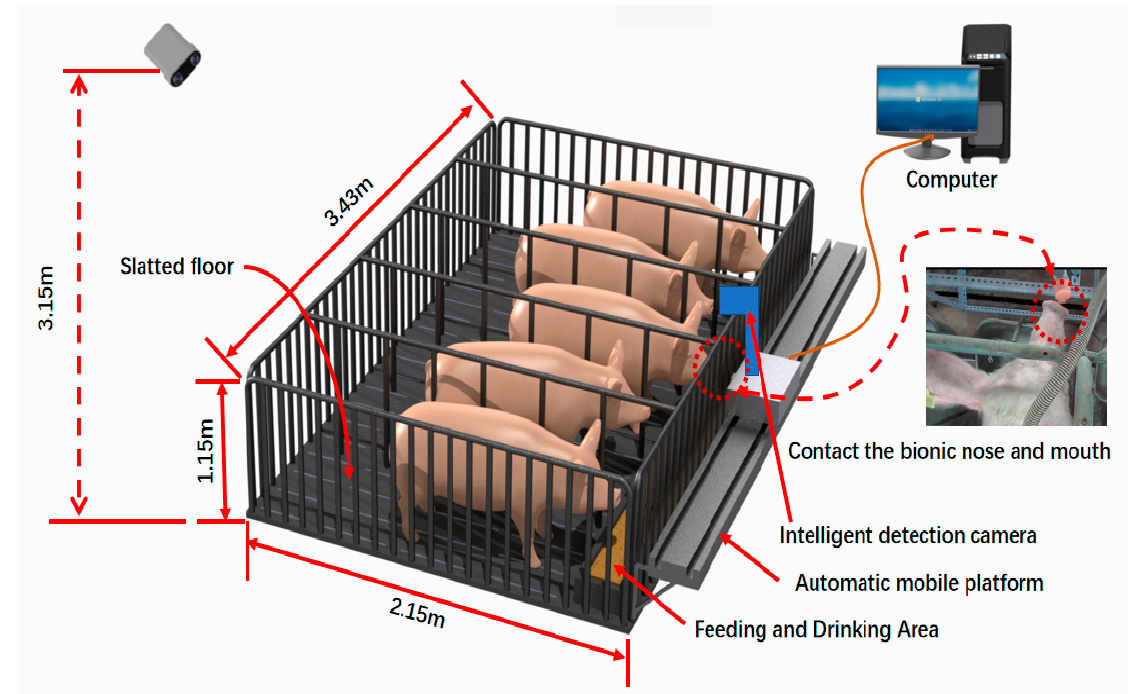
Figure 1. A rendering of the test platform.